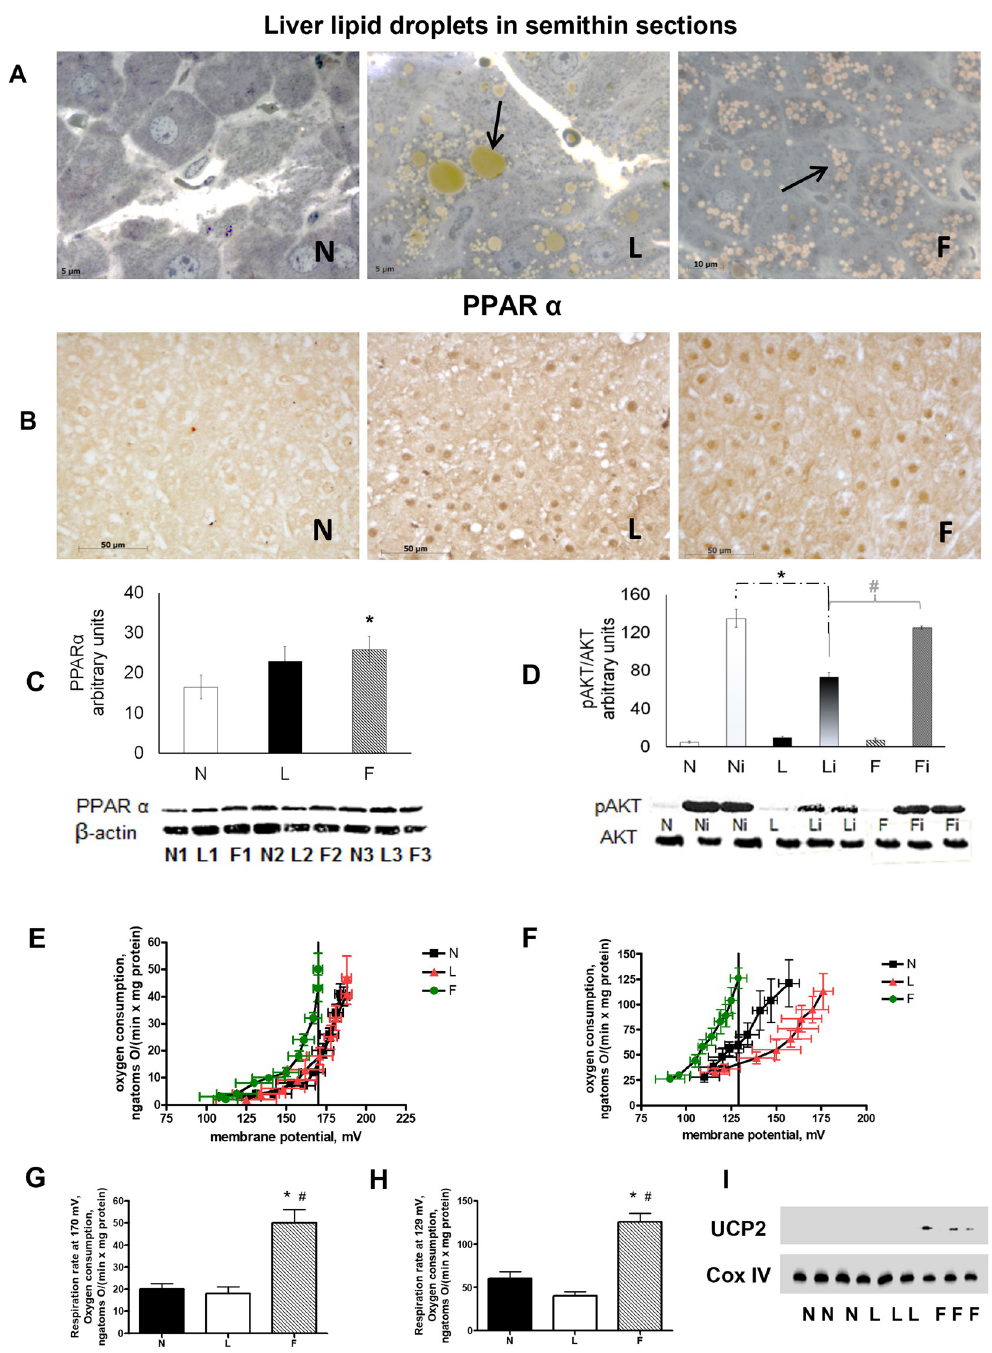
Fig 1. Hepatic steatosis, insulin resistance and mitochondrial efficiency. ( A ), Representative semi-thin liver sections stained with toluidine blue from N, L and F rats showing the presence and the relative abundance of lipid droplets in HF-fed rats. ( B ), Immunohistochemical reaction and ( C ), immunoblot for PPAR α . The intensities of the bands were normalised to that of β -actin. ( D ), Basal and insulin-induced AKT phosphorylation. N, L, F = sham; and Ni, Li, Fi = insulin-injected. ( E ) and ( F ), Kinetics of basal and palmitate-induced proton leaks in isolated liver mitochondria. ( G ) and ( H ), Respiration rates measured by interpolation at 170 mV or 129 mV for basal and palmitate-induced proton leaks, respectively. Data are means ± SE for 8 rats in each group. � P < 0.05 vs. N rats. #P < 0.05 vs. L rats. ( I ), Immunoblot for UCP2. Thin immunoreactive bands were evident only for F groups. The intensities of the bands were normalised to that of Cox